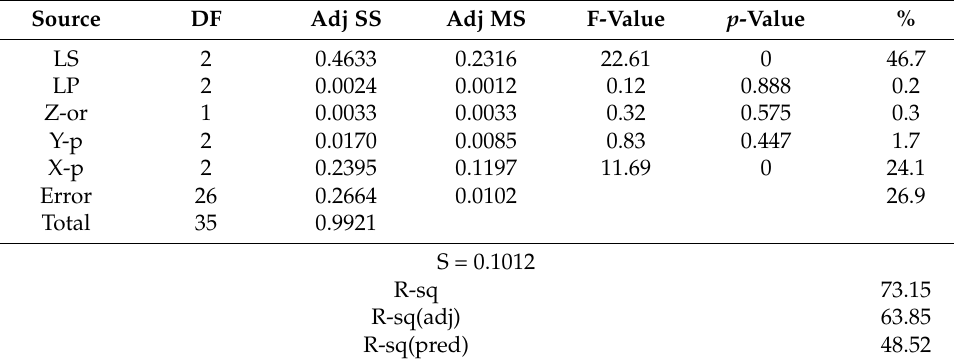
Table 4. ANOVA for the DA.